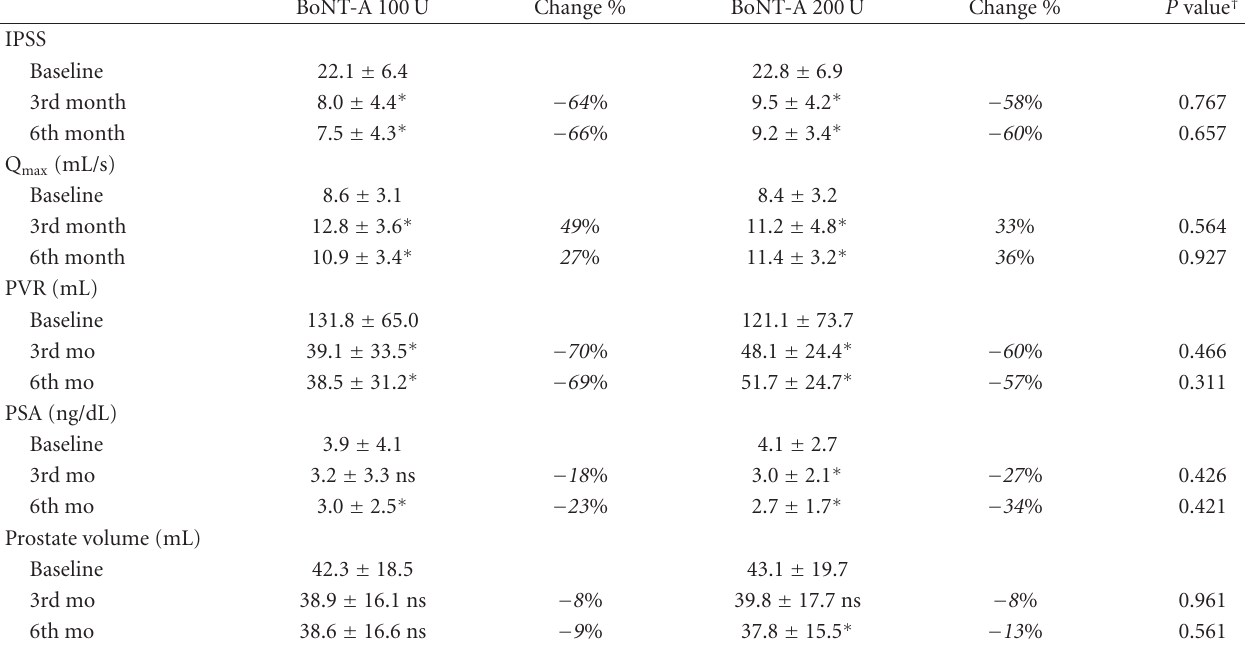
Table 2: Mean and percentage change from baseline of International Prostatic Symptom Score (IPSS), maximum urinary flow rate (Q max ), pos-void residual volume (PVR), PSA levels and prostate volume after 3 and 6 months of treatment.